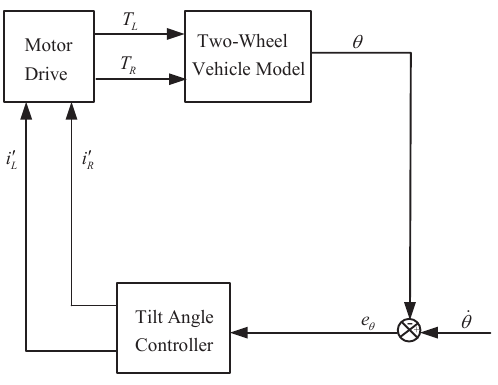
Figure 9. The experiment focused on the tilt angle control ( ˜ x = θ ) only, due to the inherit complexity and difficulty in the two-wheel vehicle system (TWVS).